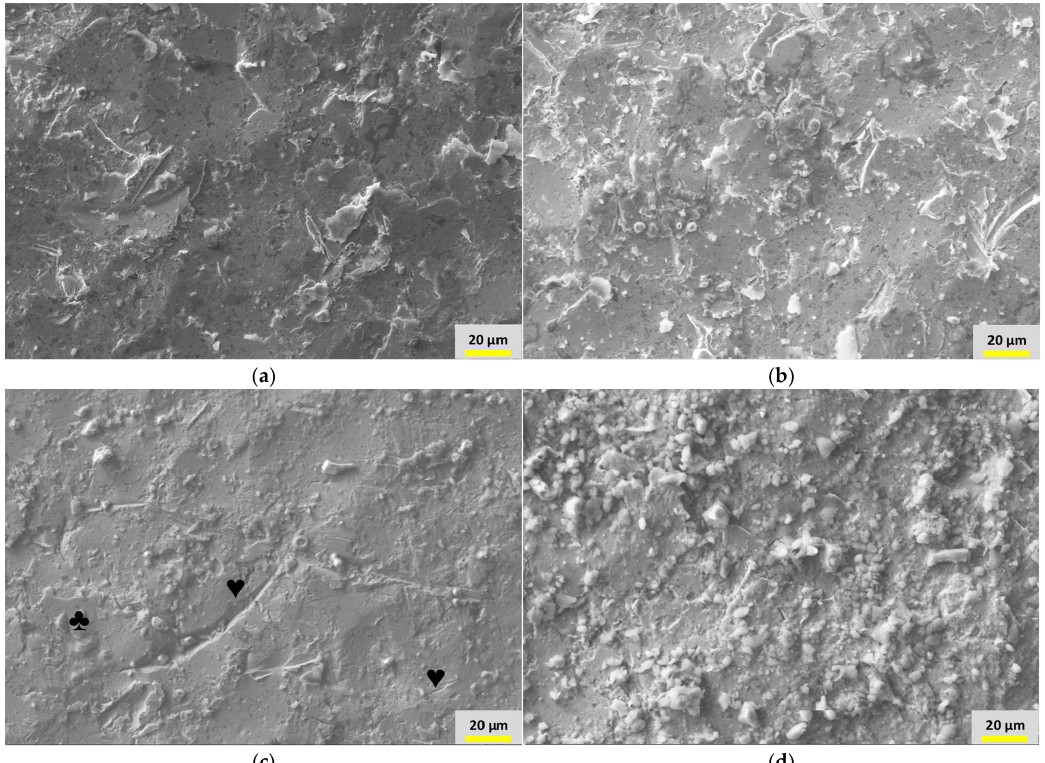
Metals 2022 , 12 , x FOR PEER REVIEW Figure 14. SEM photographs of carbon steel samples in position P3 at 32 days ( a ), 74 days ( b ), 120 days ( c ), and 241 days ( d ) of exposure.